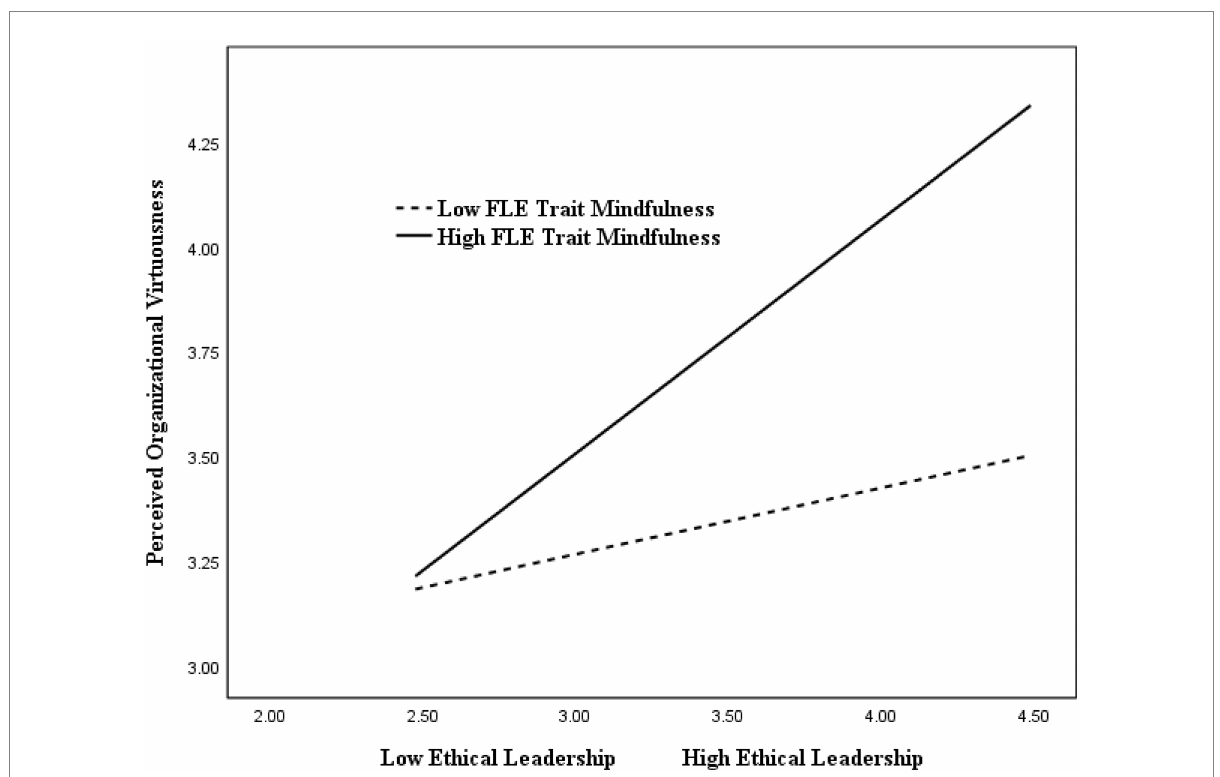
FIGURE 2 FLE trait mindfulness as a moderator of the relationship between ethical leadership and perceived organizational virtuousness.